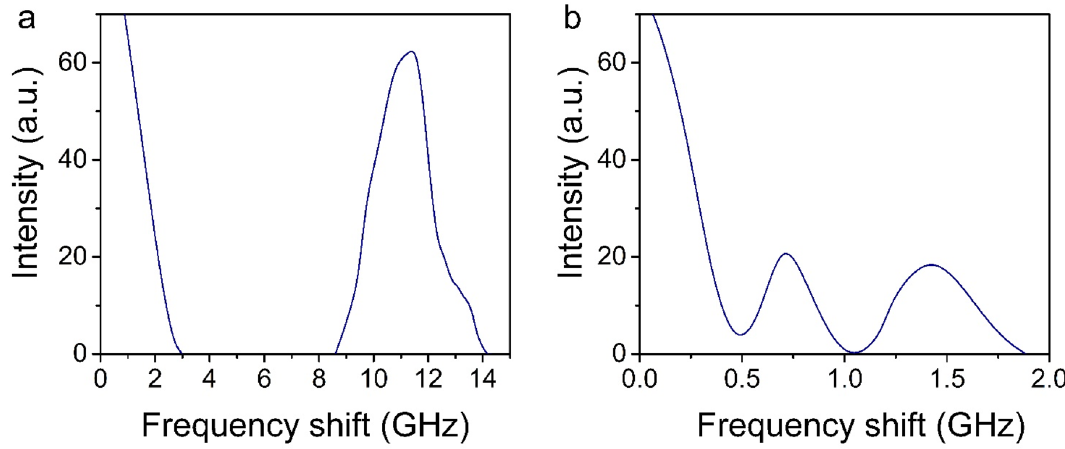
Figure 2. Spectrum of the forward-scattered SLFRS obtained by Fabry–Perot interferometer with the range of dispersion ( a ) 30 GHz ( b ) 5 GHz. l = 0 l = 1 l =